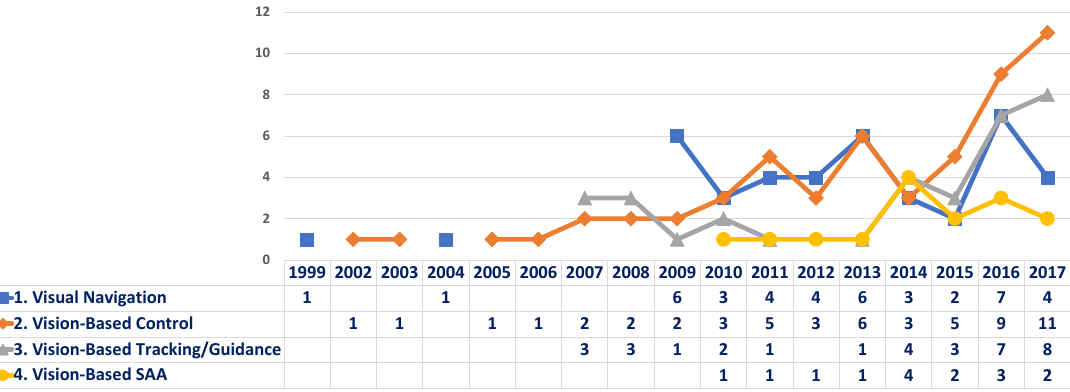
Figure 10. Annual trend per